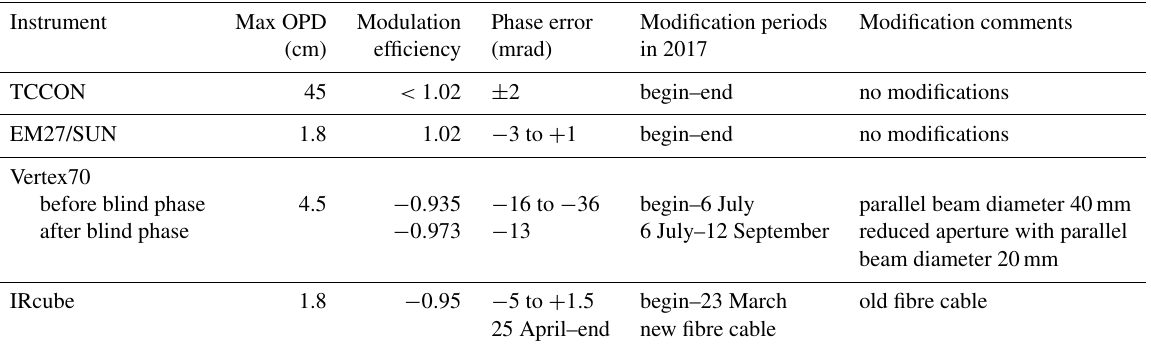
Table 3. Instrumental line shape characteristics and modifications of the participating instruments.